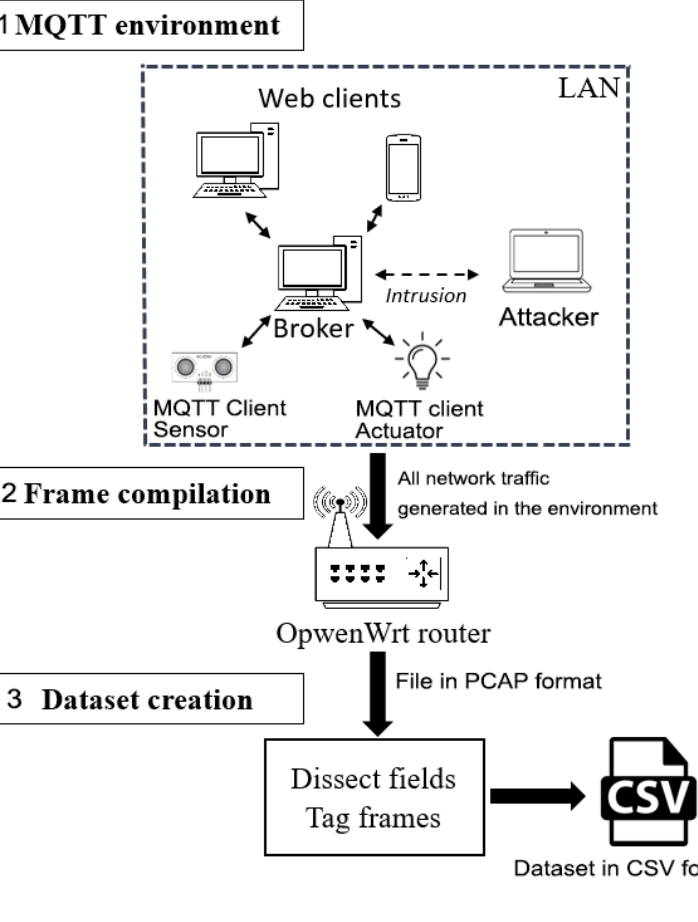
Figure 1. Intrusion dataset